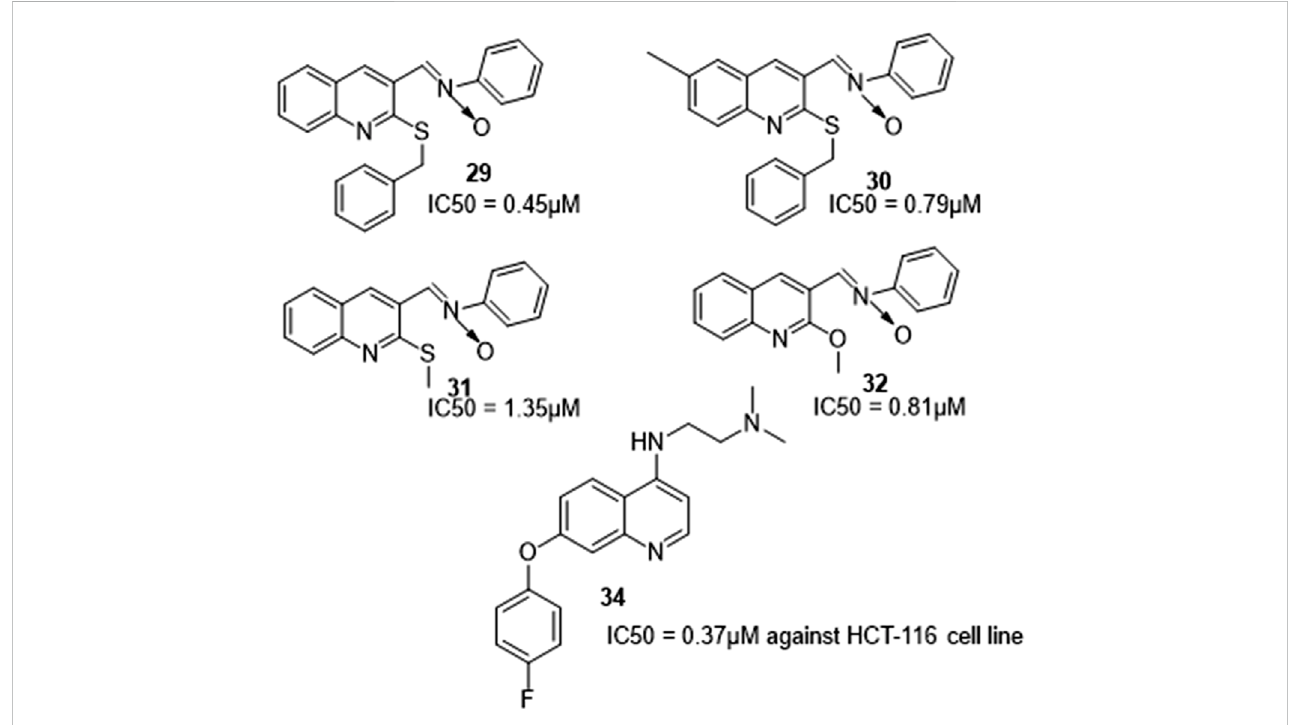
FIGURE 7 Quinolone derivatives with antiproliferative activity.